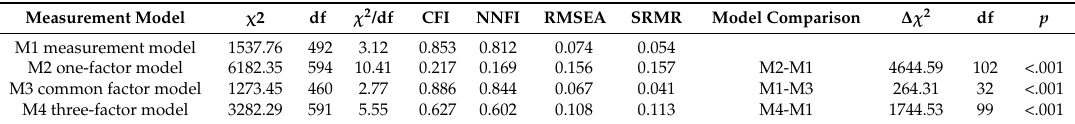
Table 1. Fit indices and models